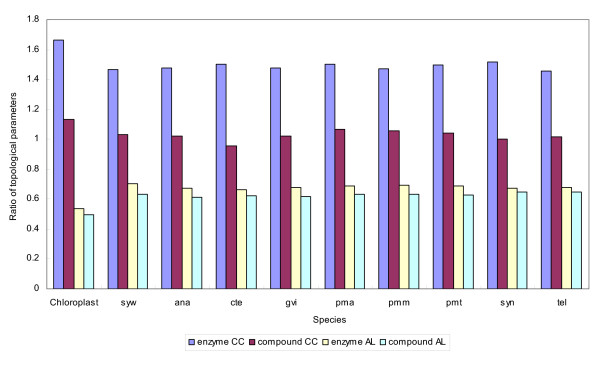
Ratio of topological properties in SubNetwork to whole network for chloroplasts and photosynthetic bacteria. CC: clustering coefficient; AL: average path length.